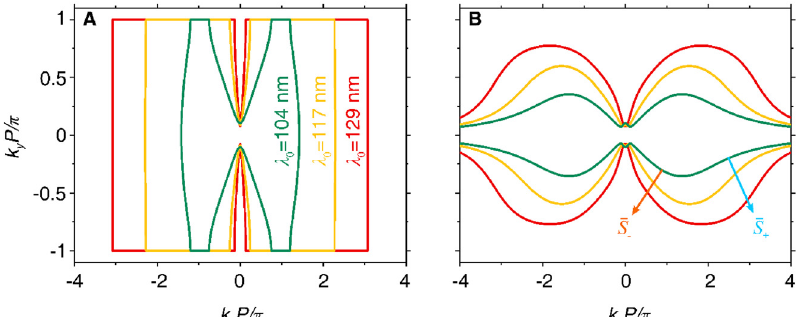
emitted by a swift charged